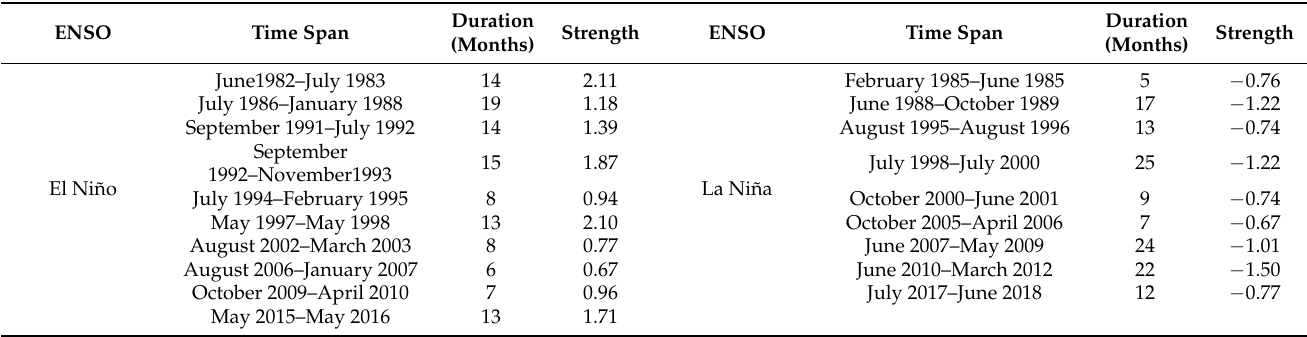
Table 4. Identification of El Niño and La Niña from 1980 to 2018 using the MEI and the NCC/CMA